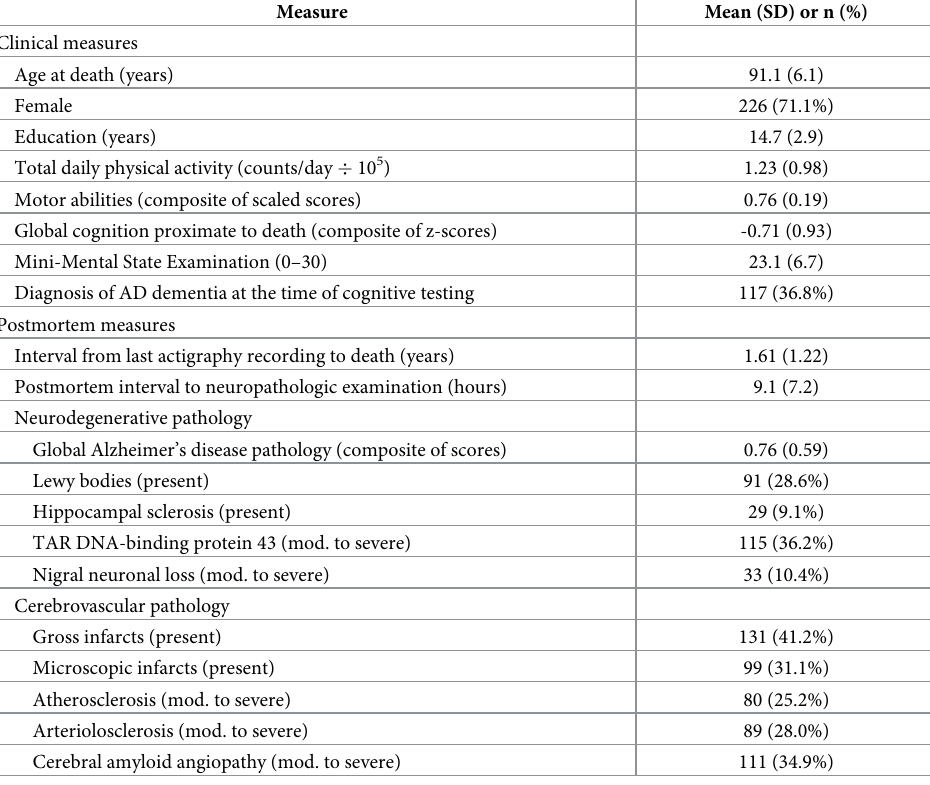
Table 1. Descriptive characteristics of the sample (N =